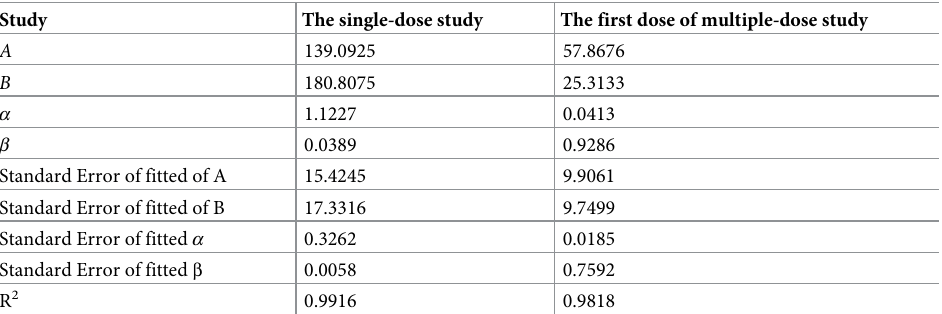
Table 2. The best-fit parameters values in the MAB1 serum concentration-time equations from the single-dose PK study and the first dose interval of the multiple-dose PK study. Study The single-dose study The first dose of multiple-dose